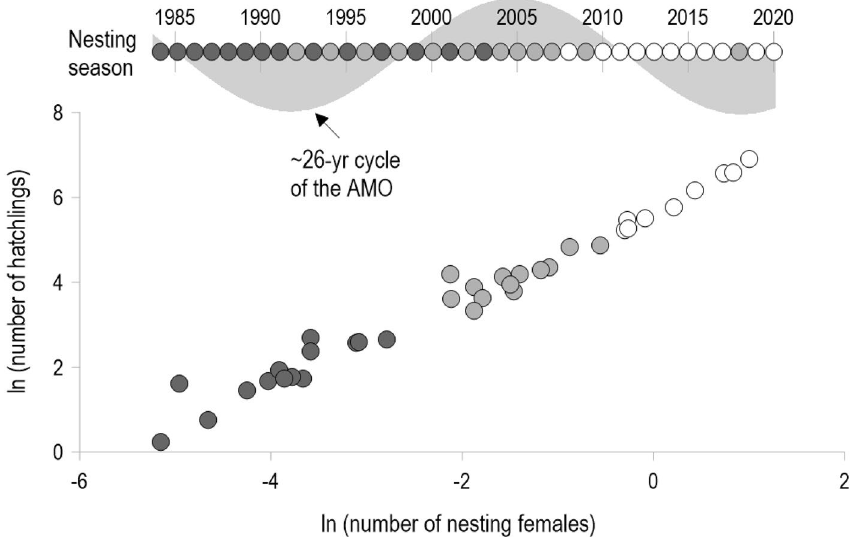
Figure 2. Relationship between the (ln) number of nesters and (ln) the number of hatchlings of the green turtle ( Chelonia mydas ) from Campeche in the southern Gulf of Mexico. The scatterplot shows three blocks of points discriminated by clustering analysis ( K -means test) 3 . The time scale in the upper part of the graph represents the study period 1984–2020, and the circles are the positions of the elements of each block (differentiated by filling patterns) with respect to the calendar years. Behind the timeline in the upper part of the graph, depicted as a light gray area, a 26-year cyclic component of the Atlantic Multidecadal Oscillation Index (AMO, sea surface temperature over the Atlantic Ocean in the Northern Hemisphere) is